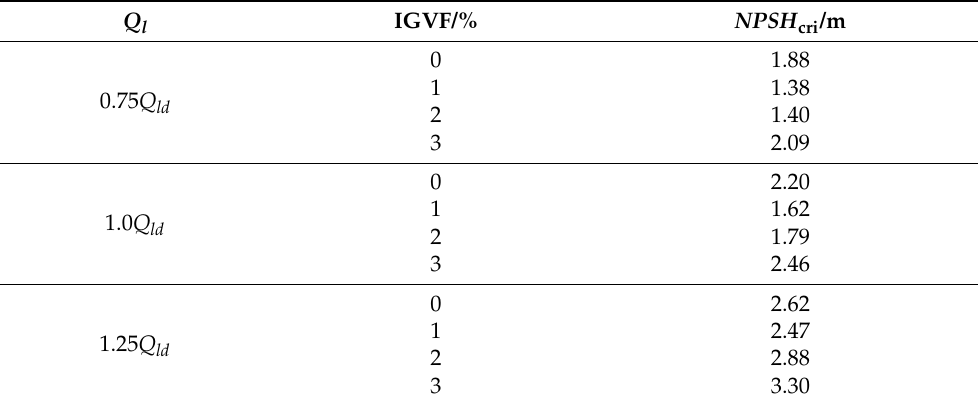
Table 2. NPSH cri of the model pump under different